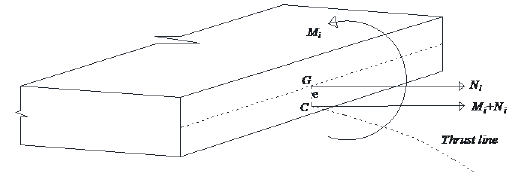
Figure 2. Center of thrust at a cross-section.